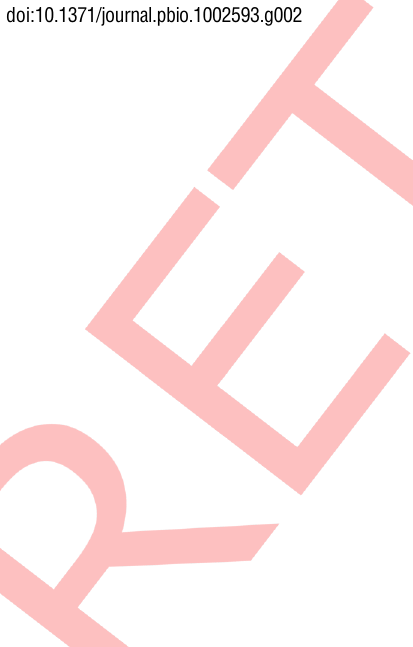
Fig 2. Classification accuracyof Patient F. LinearSVM CA across “trainingsessions—offline CA” (histogram in grey), “feedback sessions—onlineCA” (green dot), and “open questionsession—online CA” (plus sign in red), obtained using (A) relative changein O 2 Hb, (B) EEG, and (C) EOG data. The classification accuracy reportedhere is daywise, as all the “trainingsessions” in a day were used to calculatethe averageclassification accuracy of all the “trainingsessions” in a day. In the figure panels A, B, and C, the x -axis is the number of days and the y -axis is the classificationaccuracy. The solid black and dotted horizontal lines represent the chance-level thresholdcalculatedusing the metric describedin the BCI effectiveness metric section for “training sessions” and “feedback sessions,” respectively.Since the feedbackduringthe feedbackand open questionsessions was provided using the O 2 Hb, the onlineCA of the feedbackand open questionsessions is reportedonly for the f NIRS data. Fig 2 data is located at